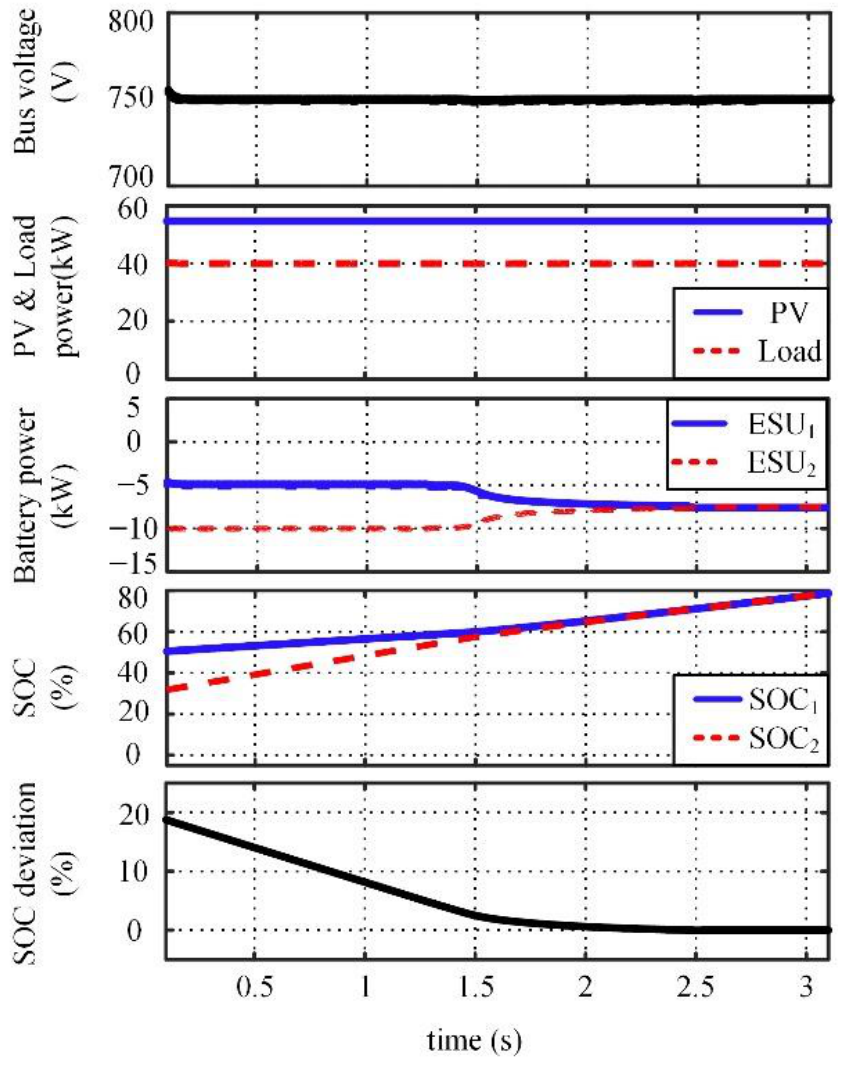
Figure 7. Waveforms of P cmax ≤ P < 2 P cmax in